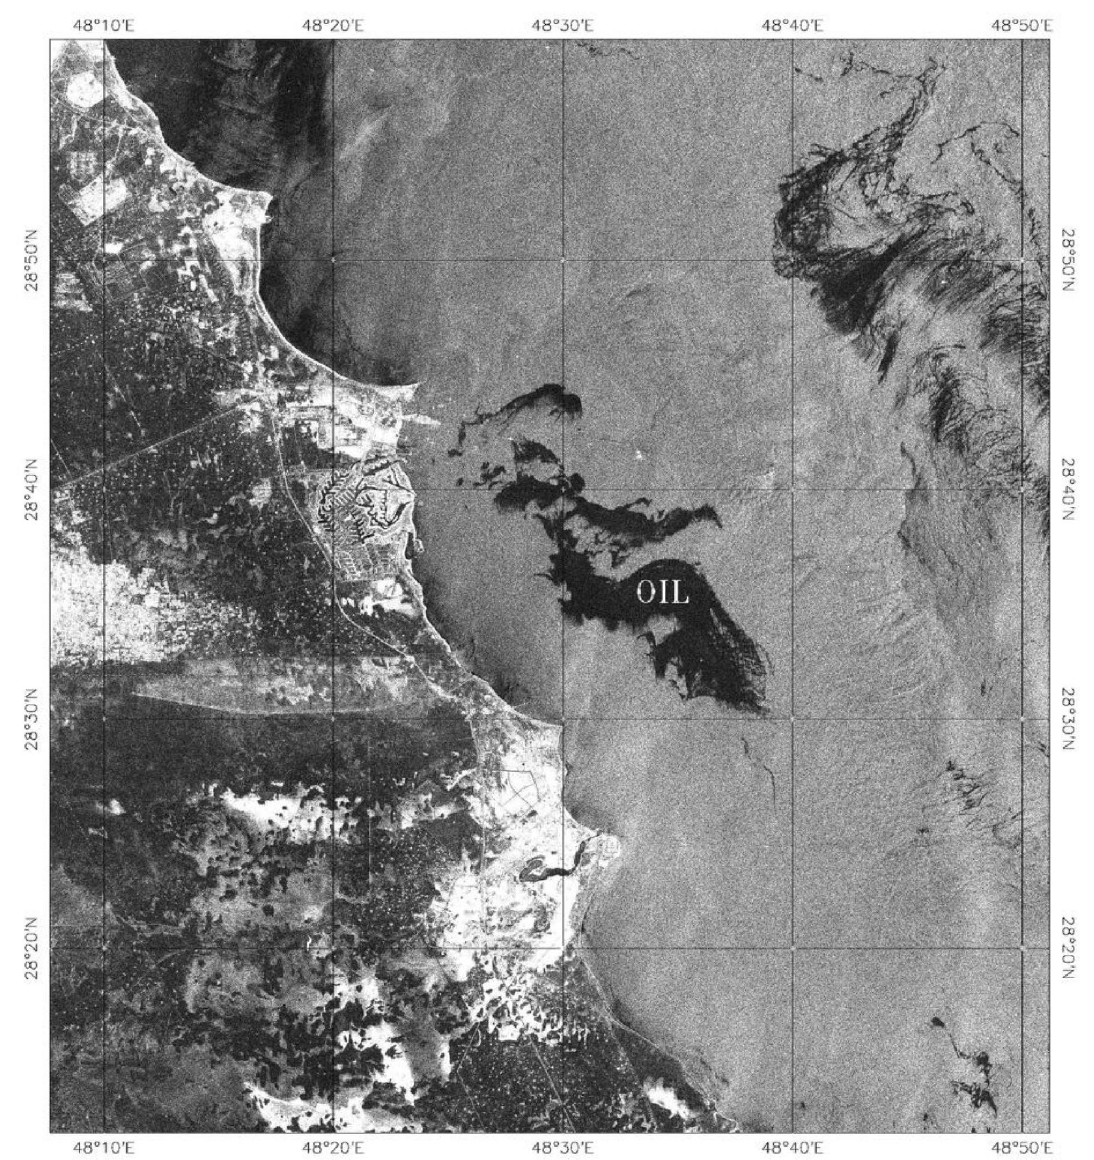
Fig. 11 Sentinel-1 imagery with deep-water horizon offshore oil spill in Kuwait on 30 June 2018. Source Kuwait Institute for Scientific Research